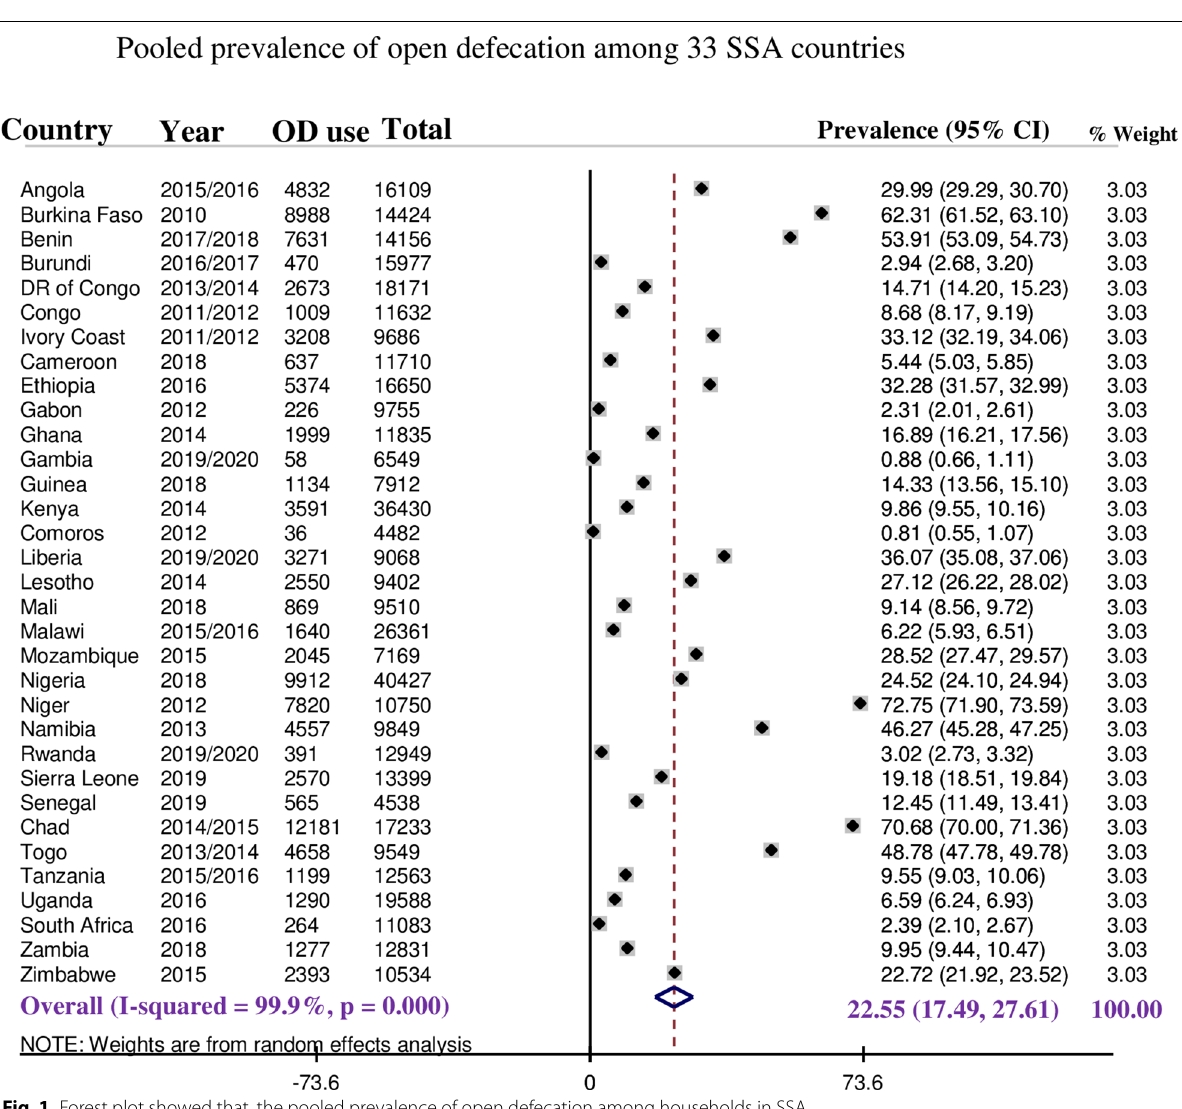
Fig. 1 Forest plot showed that, the pooled prevalence of open defecation among households in